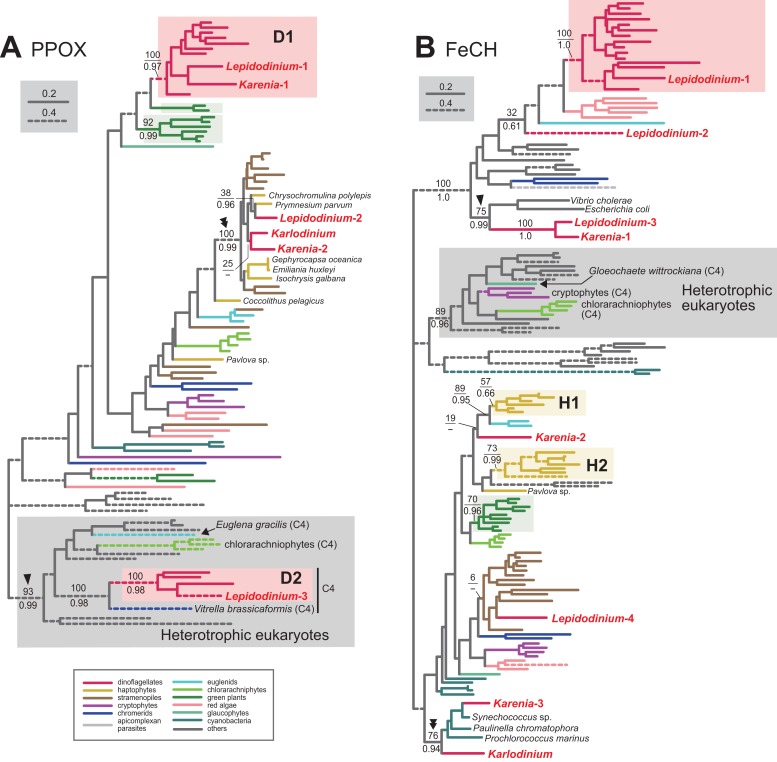
Maximum-likelihood phylogenies of two proteins involved in C5 pathway for the heme biosynthesis.The details of this figure are same as those of Fig. 2. (A) protoporphyrinogen IX oxidase (PPOX) and (B) ferrochelatase (FeCH).